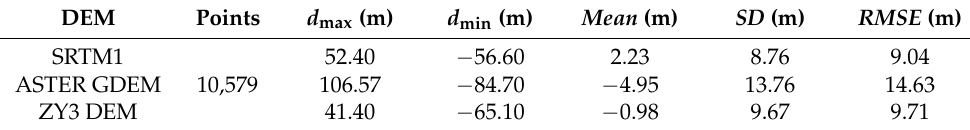
Table 4. Statistics of the vertical error values as compared with 1:50,000 DEM.